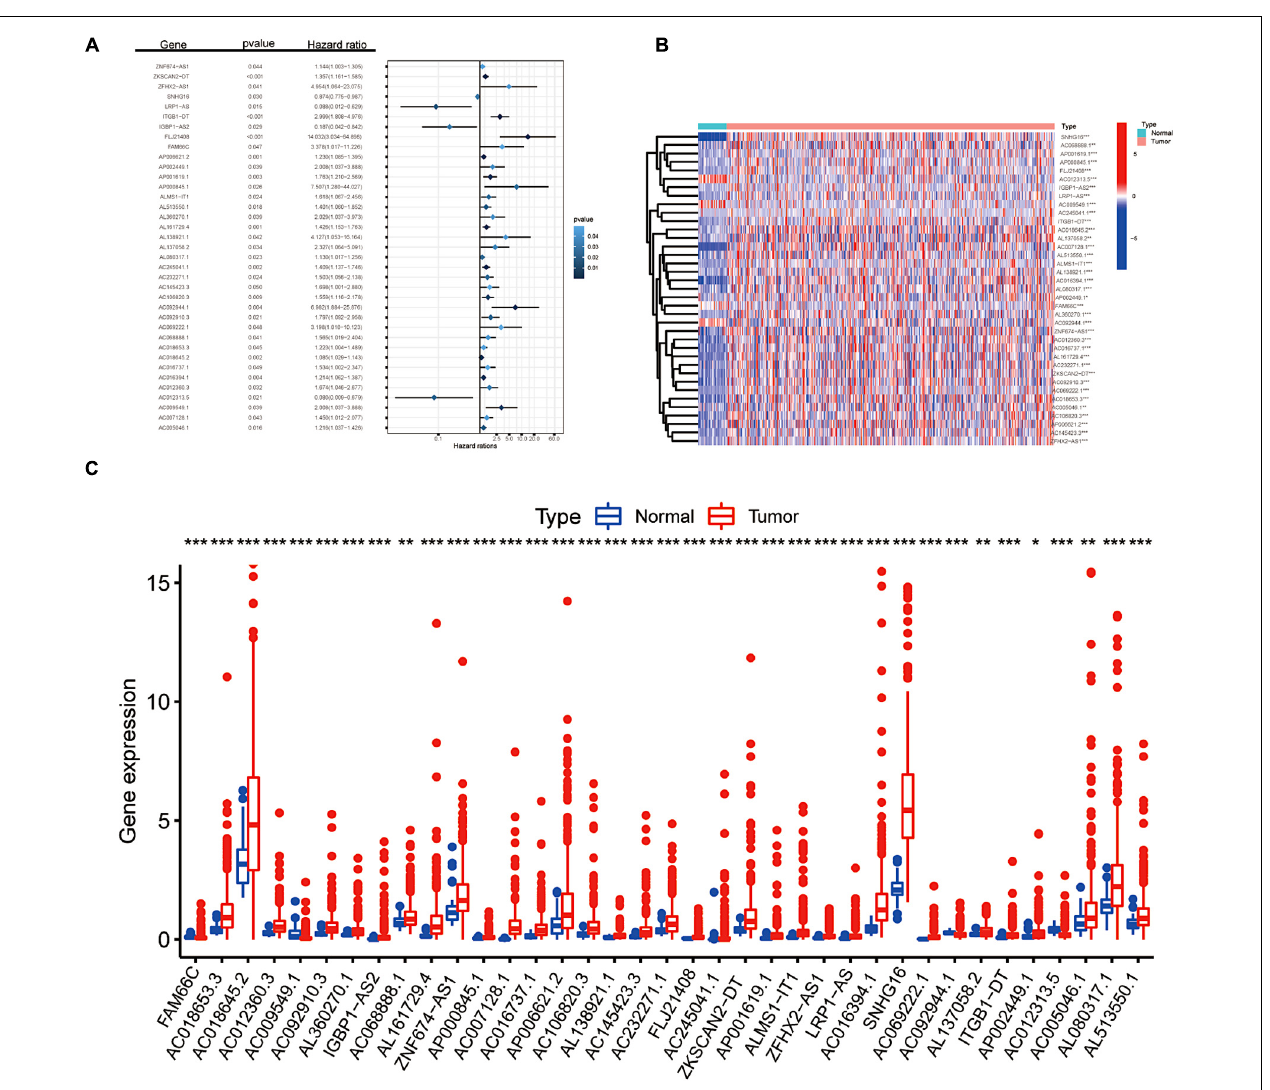
FIGURE 1 | Screening of m6A-related lncRNAs. (A) Forest plot of the prognostic ability of the 37 filtered m6A-related lncRNAs included in the prognostic signature. (B,C) Heat map and the expression level of 37 m6A-related prognostic genes in CRC tumour tissues and normal tissues. * p < 0.05; ** p < 0.01; and *** p < 0.001.